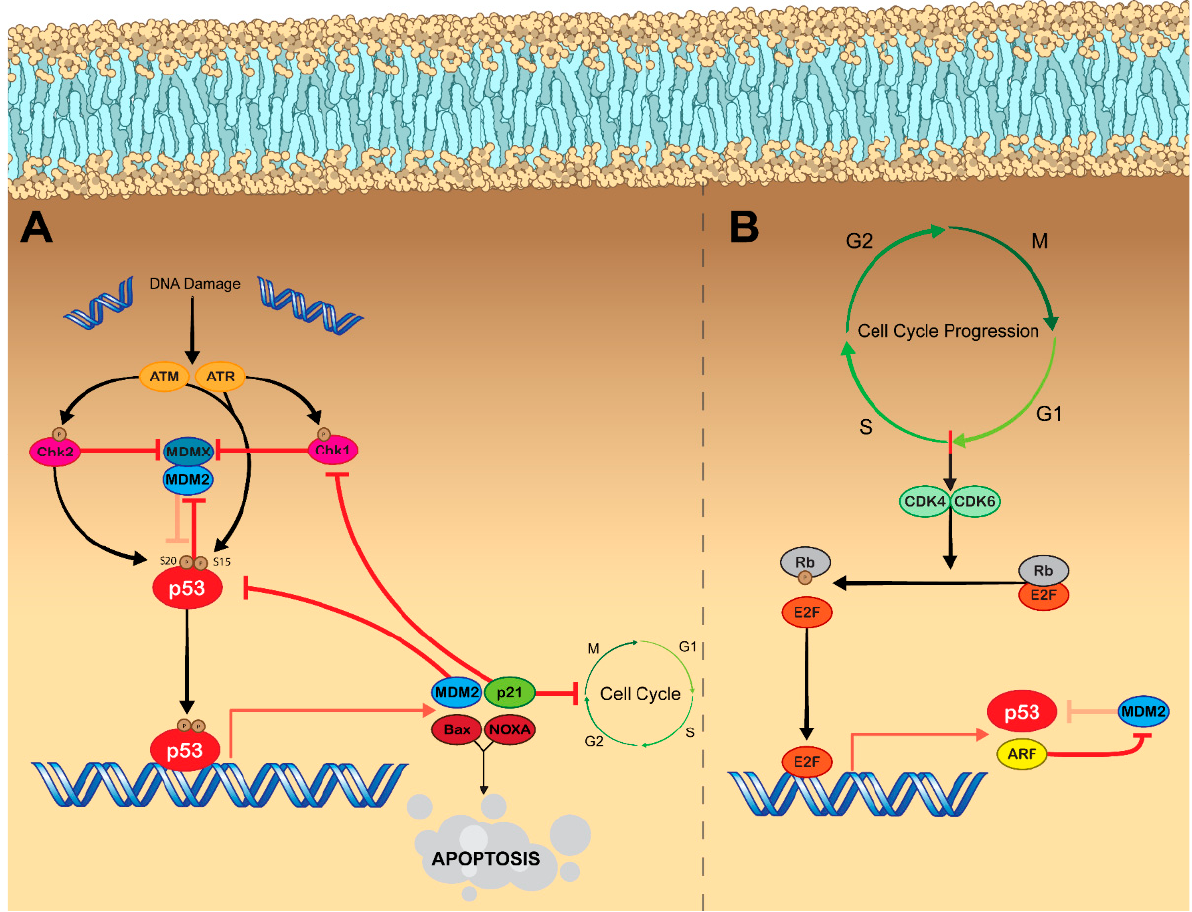
Figure 1. Mechanisms of p53 activation. ( A ) DNA damage results in p53 activation via engaging the DDR pathway. Following detection of single stranded or double stranded DNA breaks, the kinases ATM and ATR become activated. Both ATM and ATR phosphorylate p53 at Ser15. ATM also phosphorylates Chk2, which phosphorylates p53 at Ser20, while ATR phosphorylates Chk1. Phosphorylation of p53 at Ser15 and Ser20 causes it to be released from its negative regulator, MDM2. Additionally, Chk2 and Chk1 both inhibit MDMX, which functions to enhance the E3 ligase activity of MDM2 and inhibit p53. With p53 now released from MDM2, it functions as a transcription factor resulting in the expression of various tumor suppressive genes. For example, Bax and NOXA are proapoptotic proteins, while p21 functions to inhibit cell cycle progression. p53 also plays a role in regulating its own activity by facilitating the expression of more MDM2, while p21 acts to inhibit further DDR signaling by blocking the activity of Chk1. ( B ) Cell cycle progression also leads to increased activity of p53. As cells prepare to enter the S phase of the cell cycle, the kinases CDK4 and CDK6 become activated. CDK4/CDK6 phosphorylate the cell cycle inhibitor protein Rb, which causes it to dissociate from E2F. E2F is now free from inhibition and functions as a transcription factor resulting in the expression of genes that facilitate cell cycle progression. E2F also facilitates the expression of p53 as well as ARF, which functions as an MDM2 inhibitor—therefore engaging p53 signaling. E2F can also facilitate nuclear accumulation of p53 by blocking its nuclear export signal. Legend: Arrows represent activation pathways, hammers represent inhibition, faded ham- mers represent inhibitory pathways that are being repressed by the signal pathway. Abbreviations: ATM, ataxia–telangiectasia mutated kinase; ATR, ataxia-telangiectasia, and Rad3-related kinase; Chk1/Chk2, checkpoint kinases 1&2; MDM2, mouse double minute 2 homolog; MDMX mouse double minute X; CDK4/CDK6, cyclin-dependent kinases 4&6; Rb, retinoblastoma protein; E2F, E2 factor; ARF, alternative reading frame